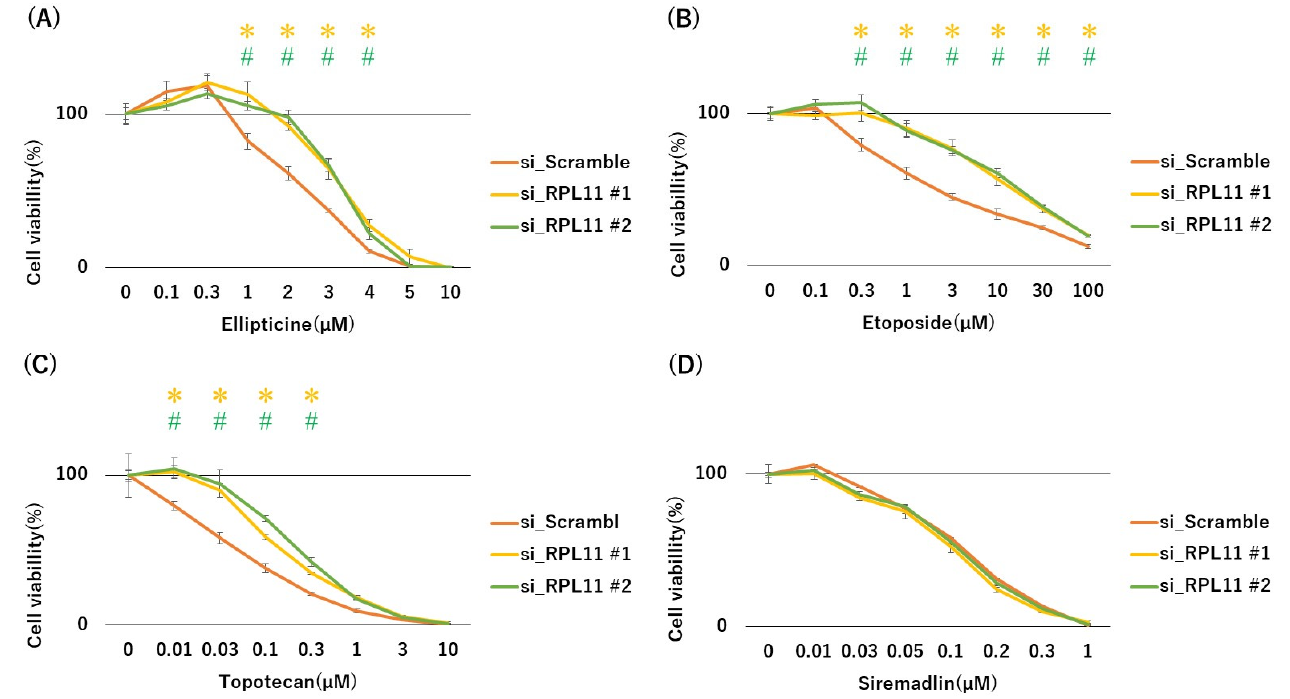
Figure 2. Effect of nucleolar stress response on topoisomerase inhibitor-mediated survival in the p53 wild-type rhabdomyosarcoma cells. RMS-YM cells were transfected with scramble, RPL11#1, and RPL11#2 siRNAs and treated with the indicated concentrations of drugs (( A ) Ellipticine, ( B ) Etoposide, ( C ) Topotecan, ( D ) Siremadlin). After 3 days of culture, the number of surviving cells was measured using the MTT assay. * p < 0.05 vs.RPL11#1 siRNA group; # p < 0.05 vs. RPL11#2 siRNA group. Results represent independent five experiments.